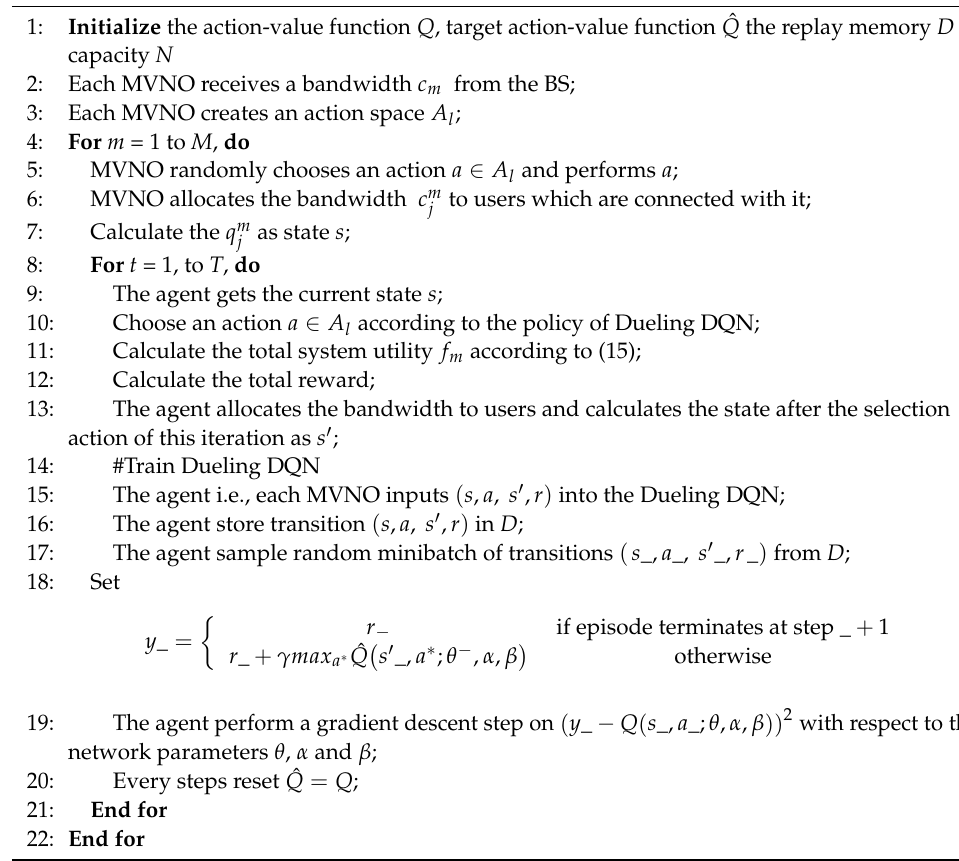
Algorithm 2 Dueling DQN Algorithm for Lower Tier Bandwidth Allocation